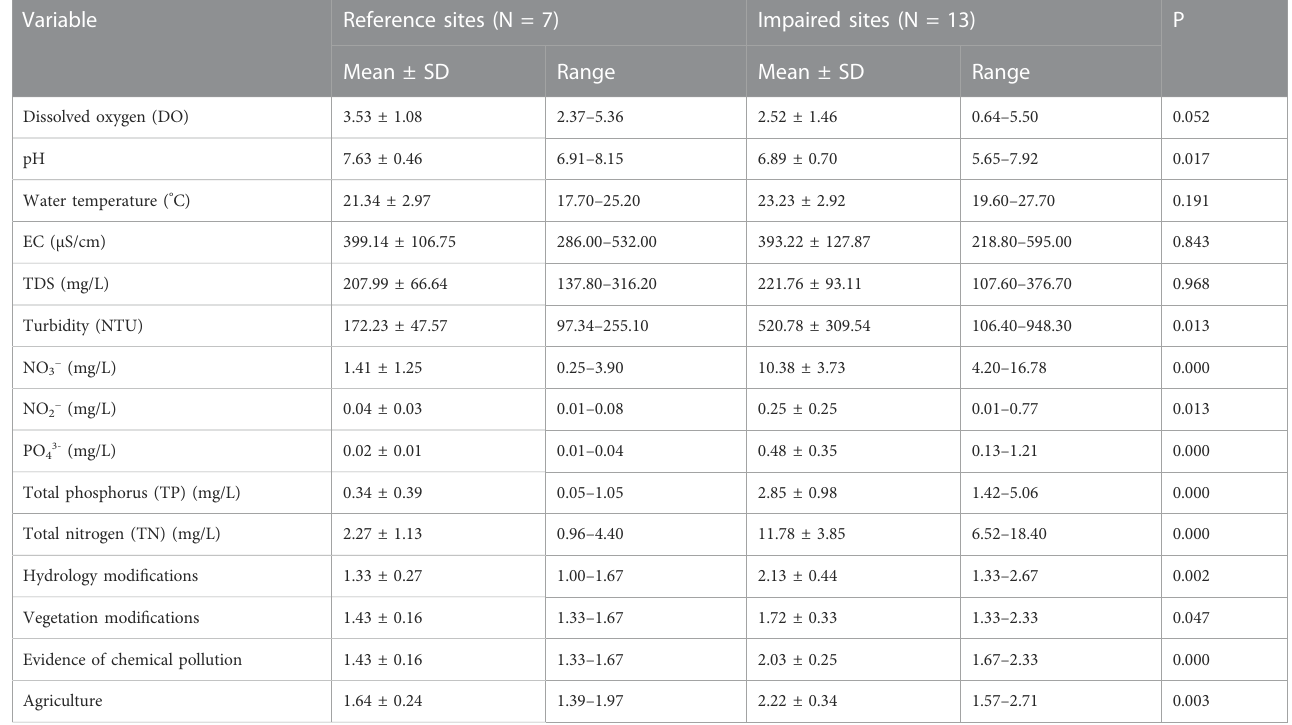
TABLE 1 Summary statistics of environmental variables in reference and impaired sites.